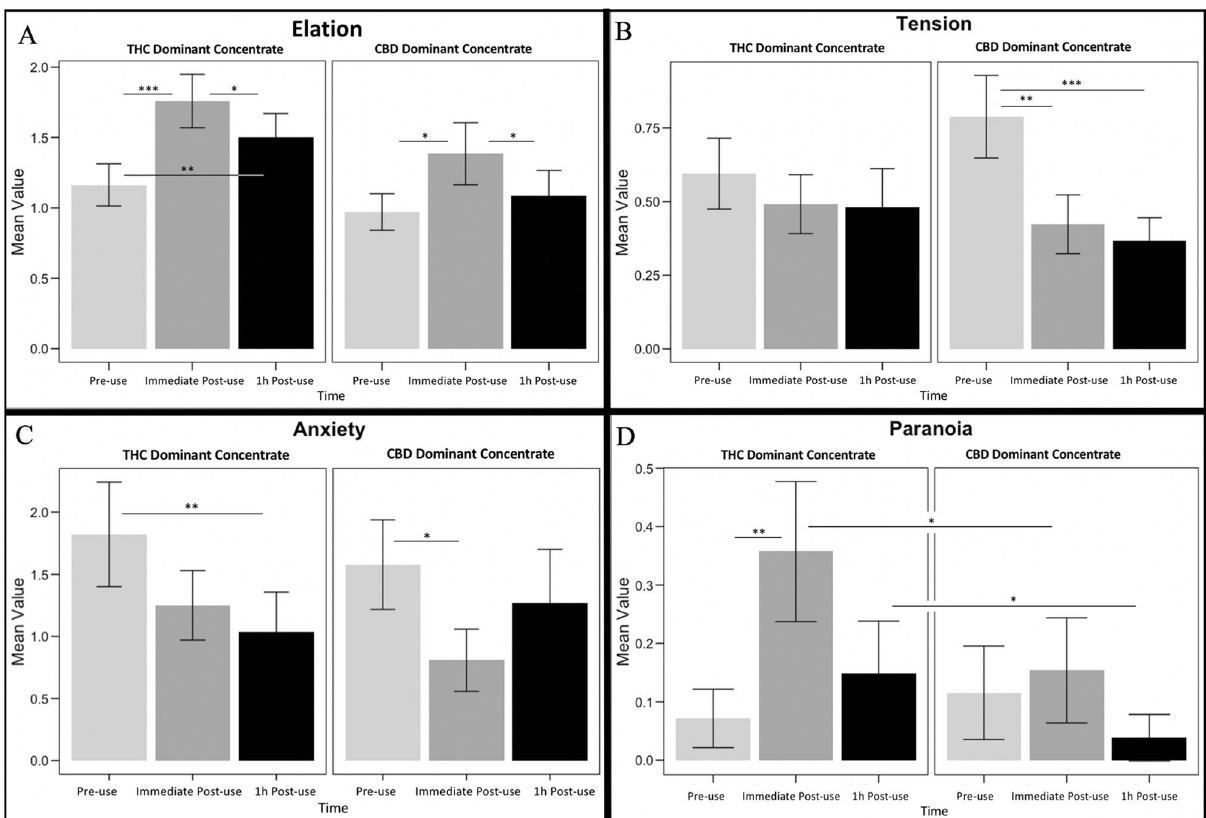
Figure 2. Subjective affect measures by timepoint and treatment group. Within group significant differences were determined by paired t-tests, and between group differences were determined by independent t-tests for the purpose of denoting differences in timepoints visually. ( A ) POMS elation (vigor) subscale; ( B ) POMS tension subscale; ( C ) anxiety measure from Marijuana Craving Questionnaire; D) POMS single item “paranoid”. (*) indicates significance at p < 0.05; (**) indicates significance at p < 0.01; (***) indicates significance at p <